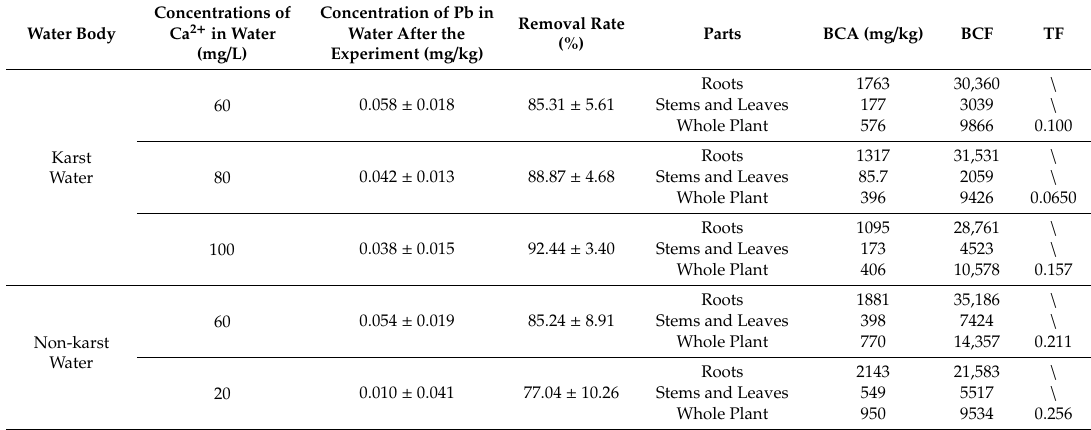
Table 4. Enrichment of Pb in di ff erent E. crassipes structures in water with di ff erent Ca 2 + concentrations.